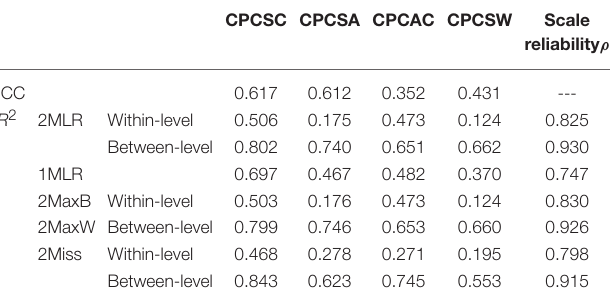
TABLE 5 | Values of ICC and R 2 on indicators in the synthetic dataset of harter’s competence measures using five SEM modeling techniques for [CN(CS), ICC] = [40(3), 0.3]. CPCSC CPCSA CPCAC